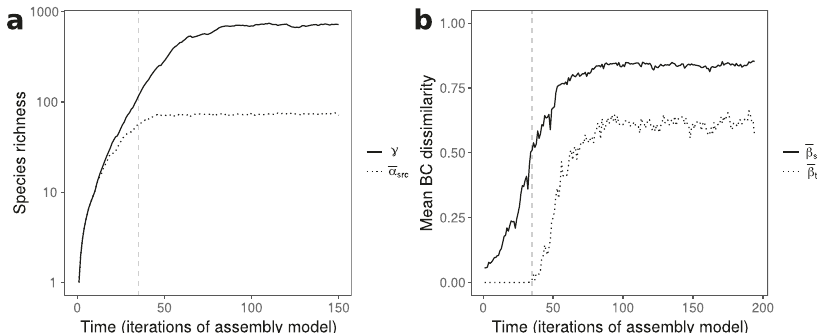
Fig. 5 The emergence of temporal turnover during metacommunity assembly. a Local species richness, de fi ned by reference to source populations only ( α src , grey) and regional diversity ( γ black) for a single metacommunity of N = 32 coupled communities during iterative regional invasion of random species. We quantify local source diversity α src as the metacommunity average of the number α src of non-zero equilibrium populations persisting when immigration is switched off (off-diagonal elements of D set to zero), since this is the component of a local community subject to strict ecological limits to biodiversity. Note the log scale chosen for easy comparison of local and regional species richness. b Increases in regional diversity beyond local limits arise via corresponding increases in spatial turnover ( β , black). Autonomous temporal turnover ( β , grey) sets in (crosses a threshold mean Bray Curtis (BC) s t dissimilarity of 10 − 2 ) precisely when average local species richness α src has reached its limit, re fl ecting the equivalence of the transition to the MA phase space and the onset of local structural instability. In both panels, the dashed line marks the point at which autonomous temporal turnover was fi rst detected. A ij = 0.3 with probability 0.3, ϕ = 10, σ 2 = 0.01, ℓ = 0.5. Both spatial and temporal turnover computed as the mean BC dissimilarity. In each iteration of the assembly model (regional invasion event), 0.1 S + 1 species were introduced. Dynamics were simulated for 2 × 10 4 unit times, with the second 10 4 unit times analysed for autonomous turnover, and a total of 10 4 invasions were